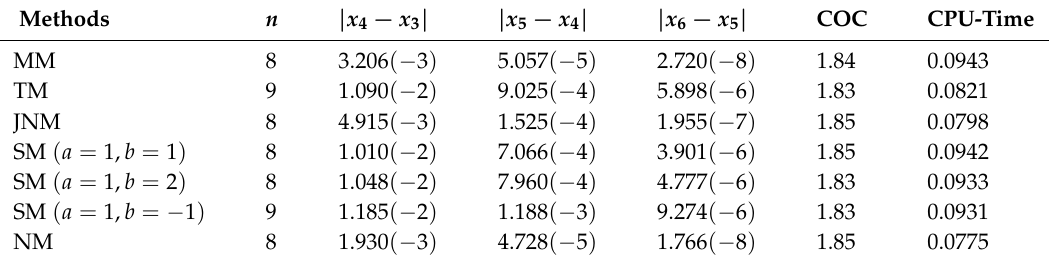
Table 5. Comparison of performance of methods for function f 5 ( x ) , taking x 0 = 1.2, x 1 = 0.9, x 2 =